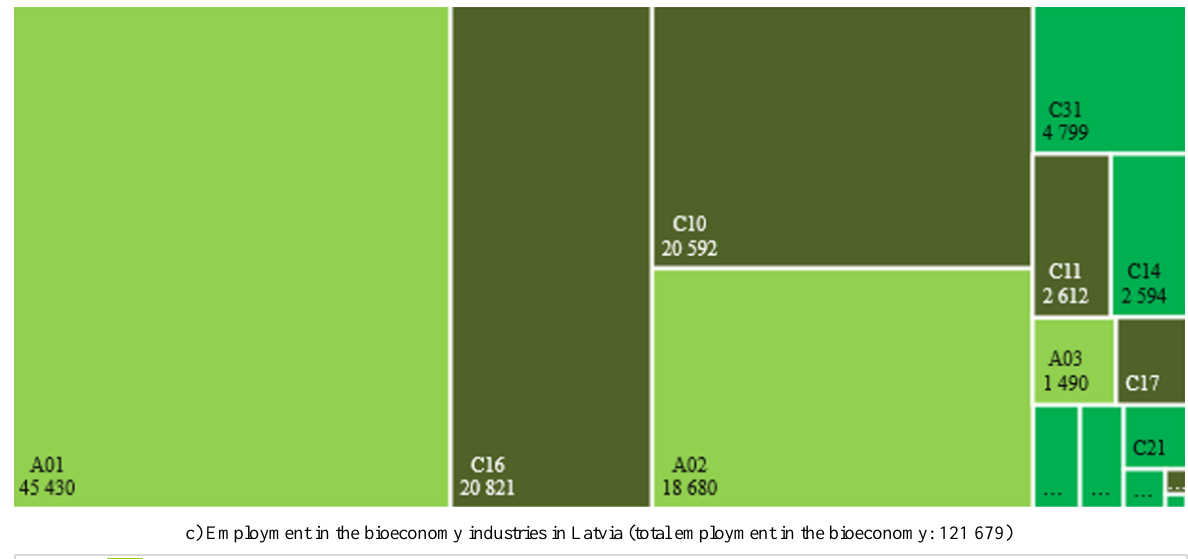
Figure 2. Turnover (million EUR) and value added (million EUR) of and employment in the bioeconomy industries